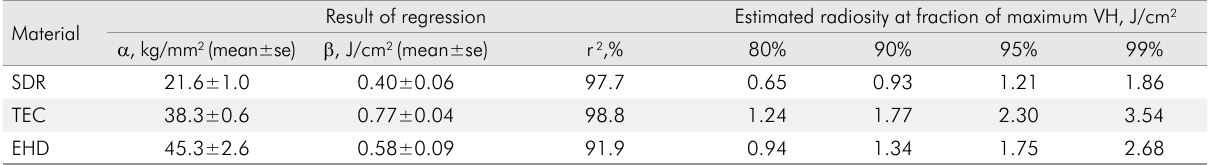
Table 2. Results of non-linear regression using eq. (1) showing the maximum hardness ( α ) and estimated radiosity at the bottom surface, when fraction of the maximum hardness is